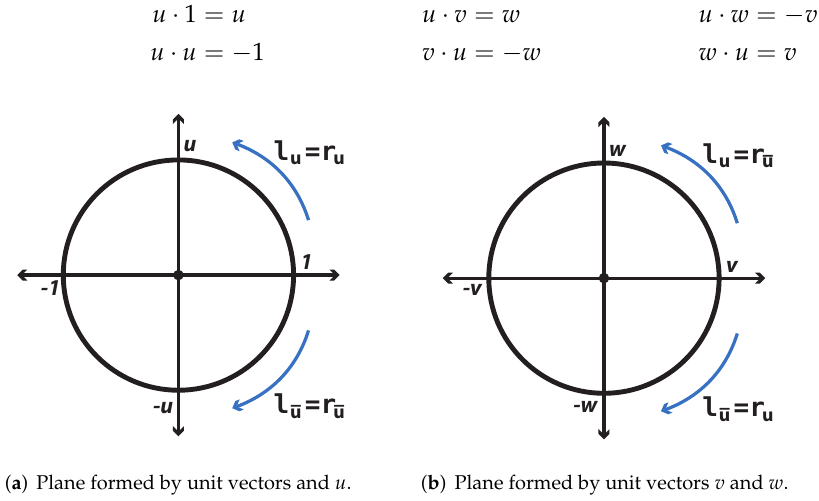
Figure 2. Decomposition of 4D space. On the plane generated by the multiplication between { 1, u } and u , the left and right generate a counter-clockwise rotation, as shown in Figure 2a. However, if we conjugate the imaginary unit u (i.e., ¯ u = − u ), the multiplication generates a clockwise rotation. In the plane spanned by { v , w } , the multiplication by u on the left of any vector is equivalent to a counter-clockwise rotation. In contrast, the multiplication by u on the right is equivalent to a clockwise rotation. When we multiply by the conjugate of u , the right and left multiplication generates a counter-clockwise and clockwise rotation,